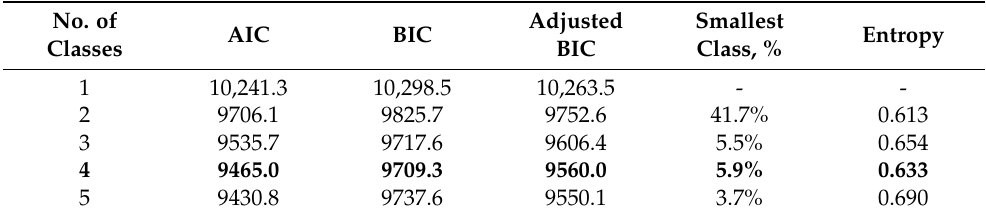
Table 2. Summary of latent class model identification and fit